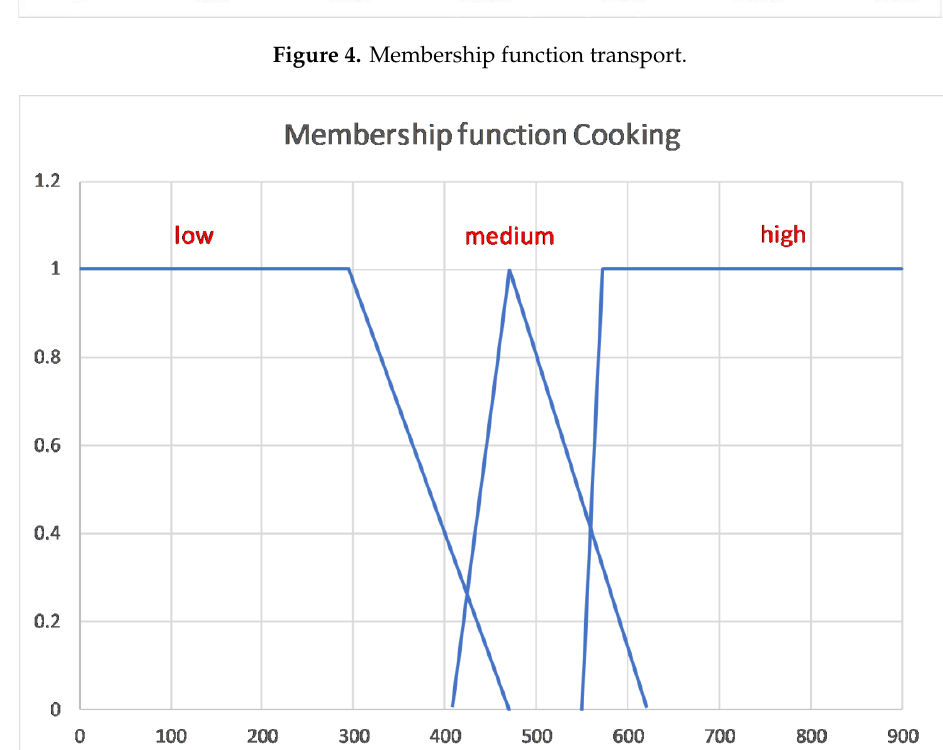
Figure 5. Membership function cooking.